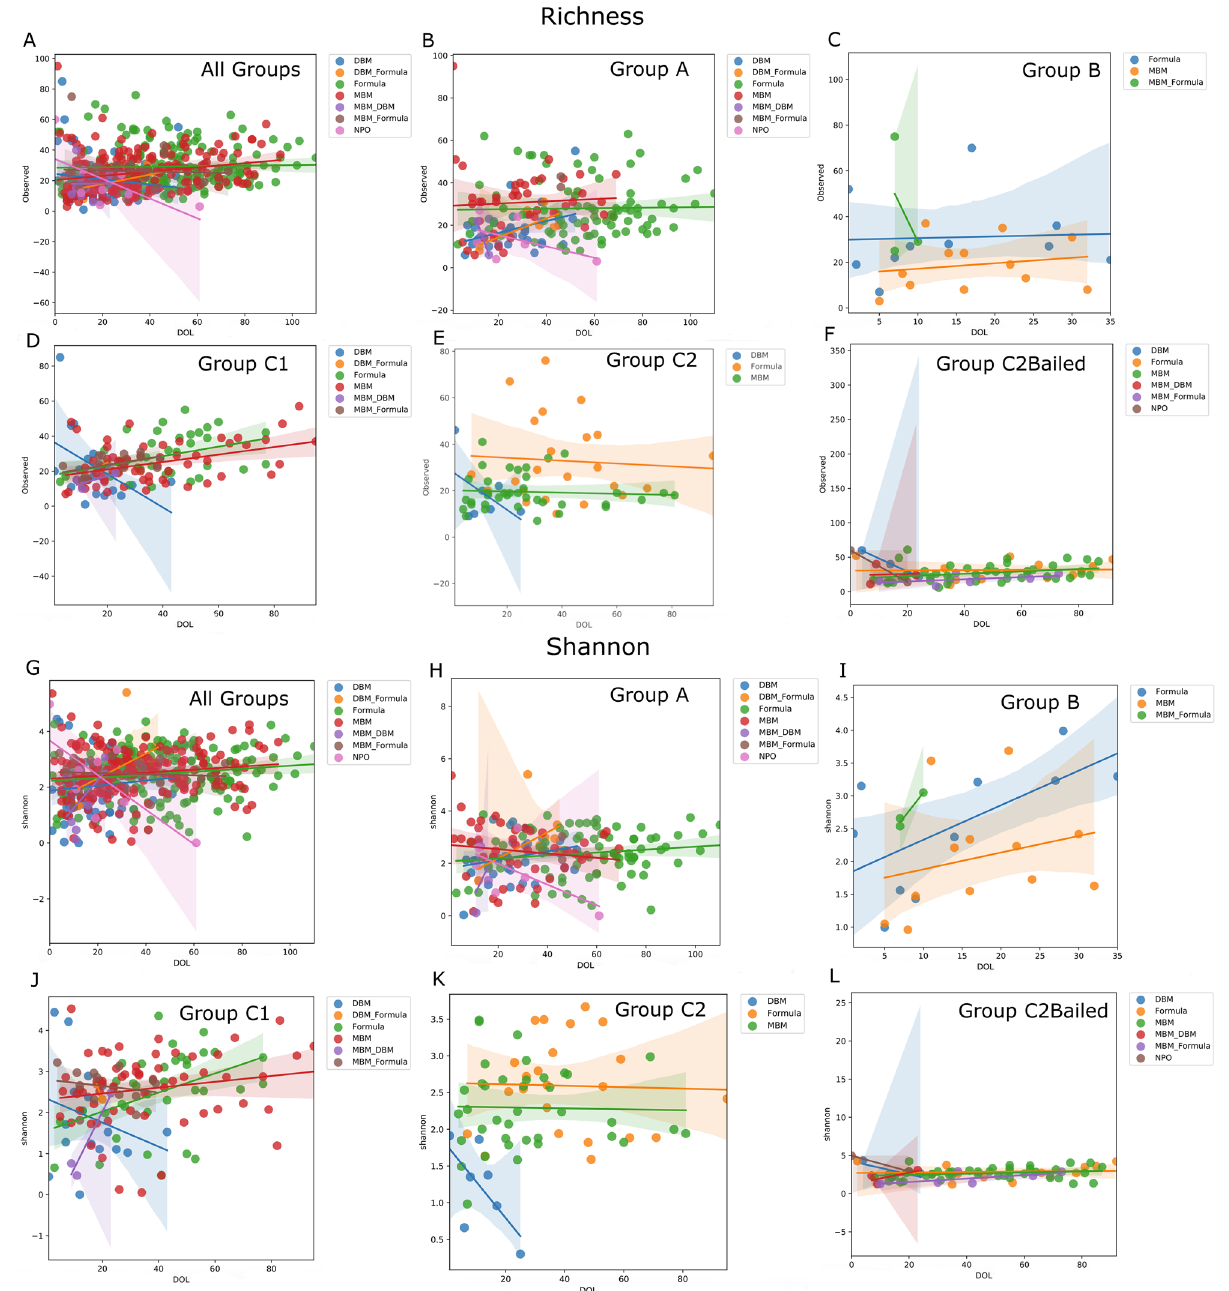
Figure 4. Linear mixed effects modelling identifies feeding effects by group over time. Linear mixed-effects results plotted as observed bacterial richness over time by group and feeding types ( A–F ) and the Shannon diversity over time by group and feeding types ( G–L ). The number of samples used in this analysis by group and by feeding type are listed in Supplementary Table